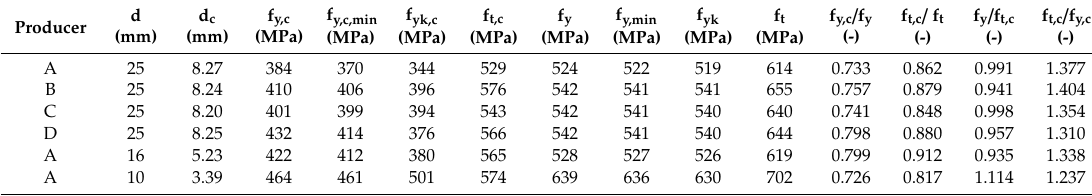
Table 3. Mechanical properties of the ribbed bars and the core.